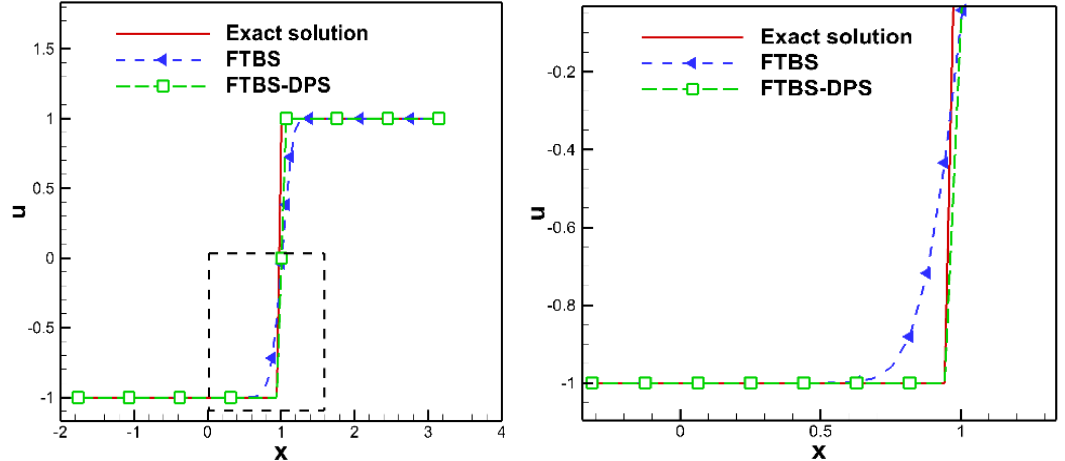
Figure 1. Solution of convection equation Figure 2. Zoomed view of the discontinuity